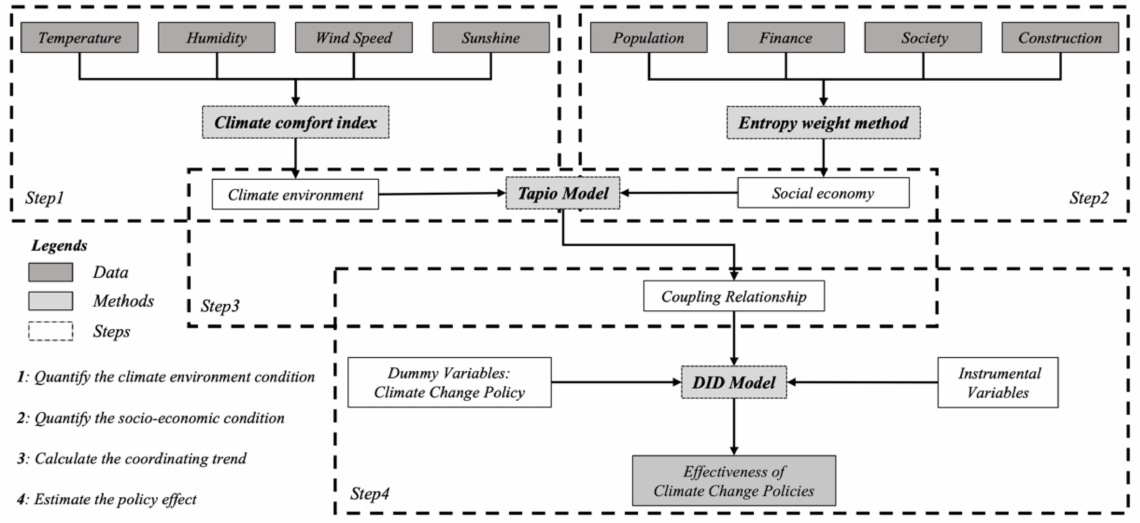
Figure 1. Research